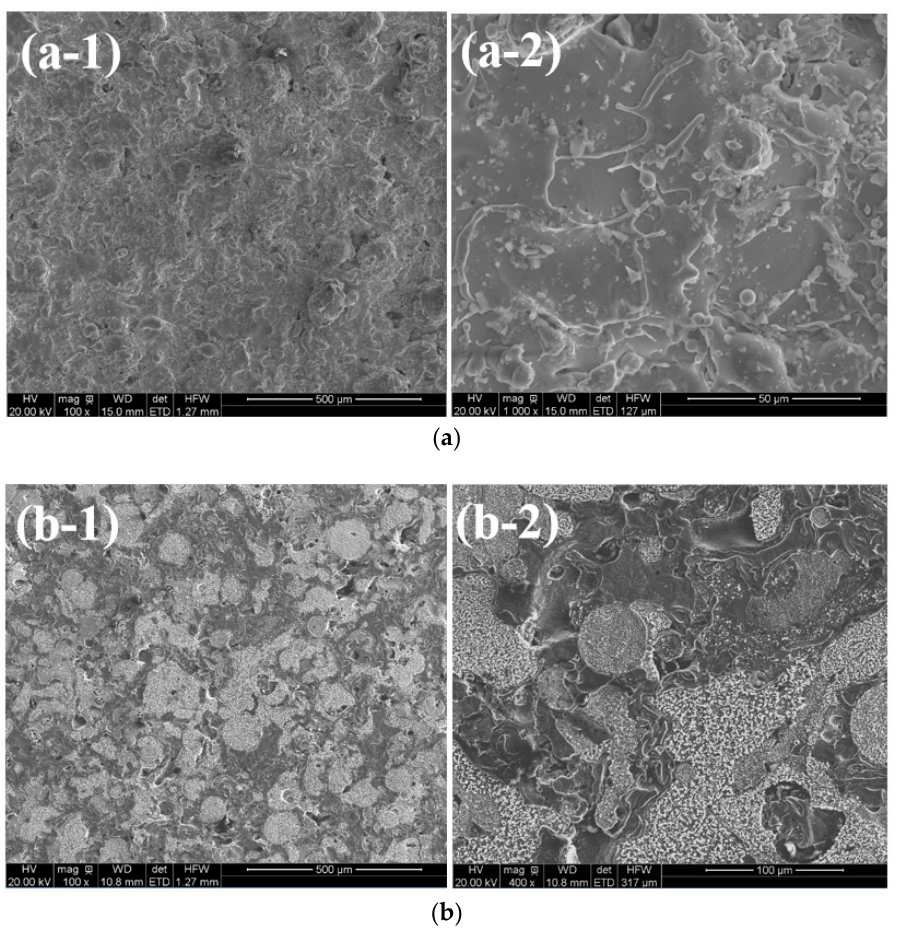
Figure 4. Typical surface view of ( a ) plasma sprayed NiCrBSi coating and ( b ) acid corrosion of plasma sprayed NiCrBSi coating. ( a-1 , b-1 ): low magnification, ( a-2 , b-2 ): high